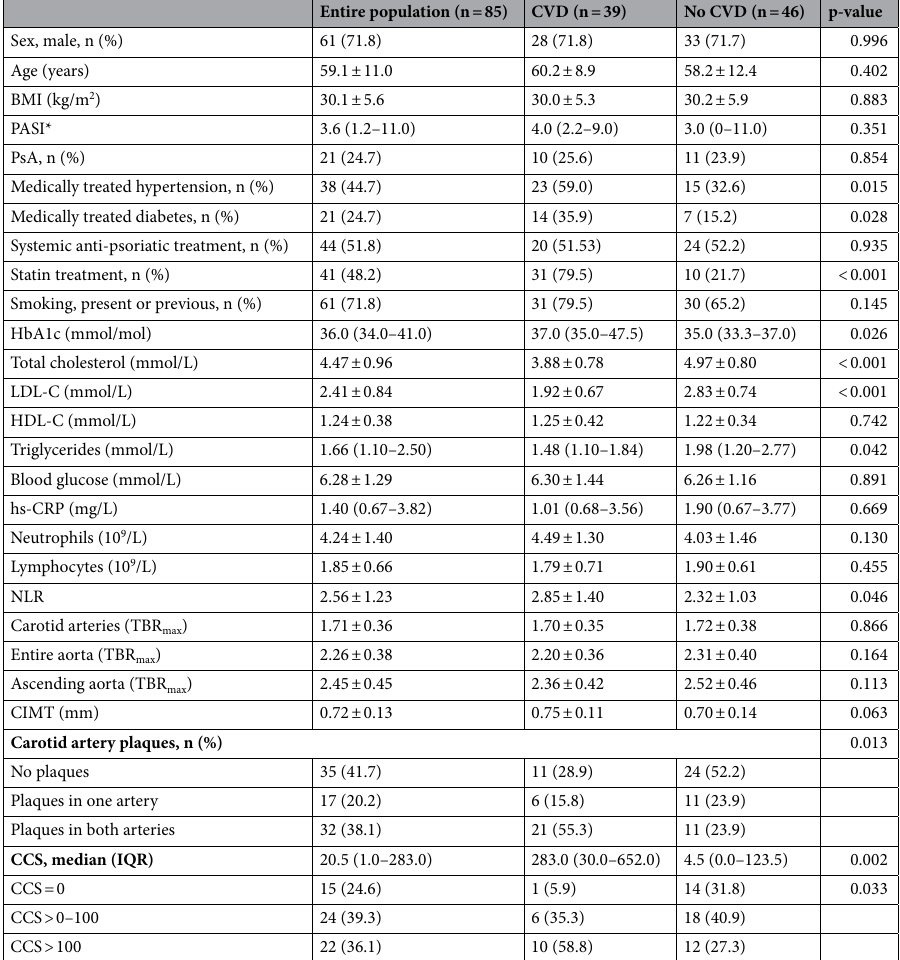
Table 1. Study patient characteristics. Parametric data are reported as means ± SDs and non-parametric data are medians (IQRs). BMI body mass index, PASI psoriasis area and severity index, PsA psoriatic arthritis, CVD cardiovascular disease, HbA1c glycated haemoglobin, LDL-C low-density lipoprotein cholesterol, HDL-C high- density lipoprotein cholesterol, hs-CRP high-sensitivity C-reactive protein, NLR neutrophil-to-lymphocyte ratio, TBR max maximum target-to-background ratio, CIMT carotid intima-media thickness, CCS coronary artery calcium score. *Approximately half of patients in each group were treated with systemic anti-psoriatic agents (see